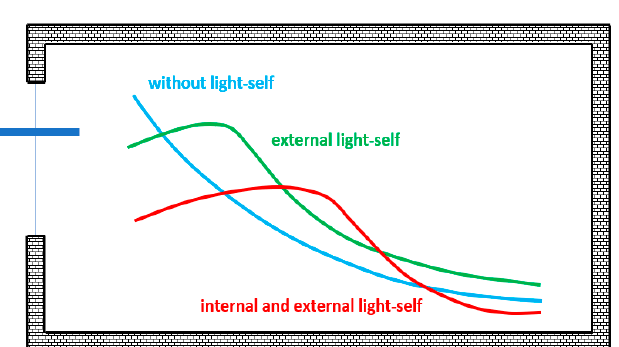
Figure 8. Illuminance qualitative tendency without and with (outdoor only or indoor/outdoor) the use of light shelf [16].